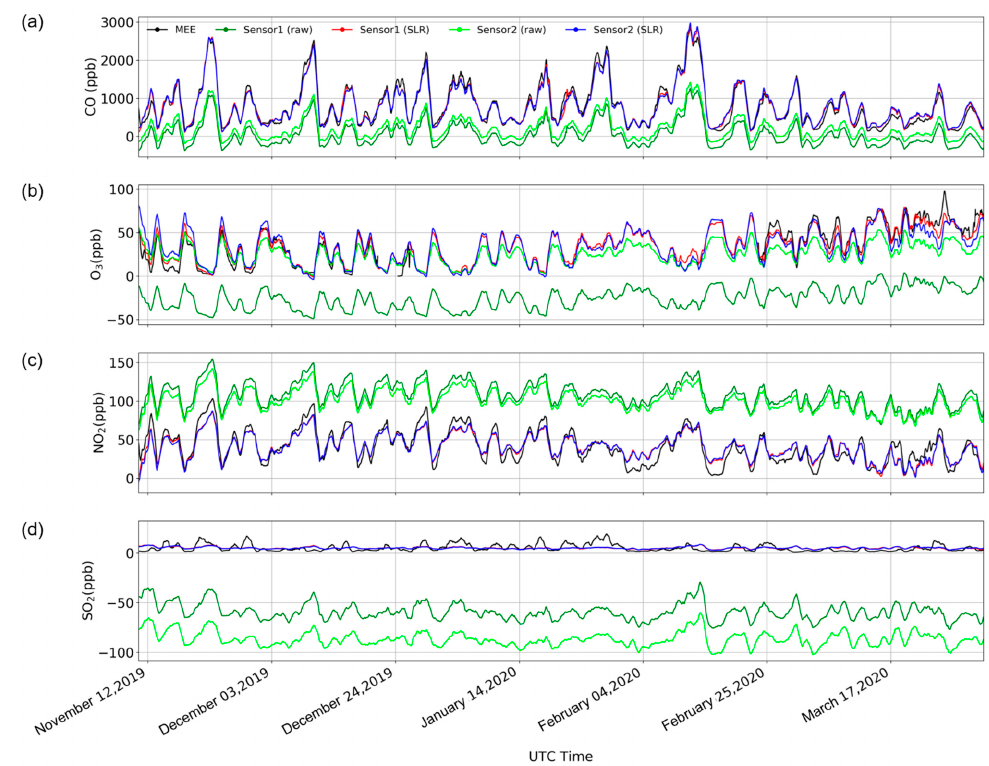
Figure 2. Comparison of ( a ) CO, ( b ) O 3 , ( c ) NO 2 , and ( d ) SO 2 volume concentrations between the Ministry of Ecology and Environment (MEE) Olympic Sports Center station and the two sensors before (raw) and after single linear regression (SLR) calibration on 10 November 2019, to 1 April 2020, in Beijing based on a 24 h rolling